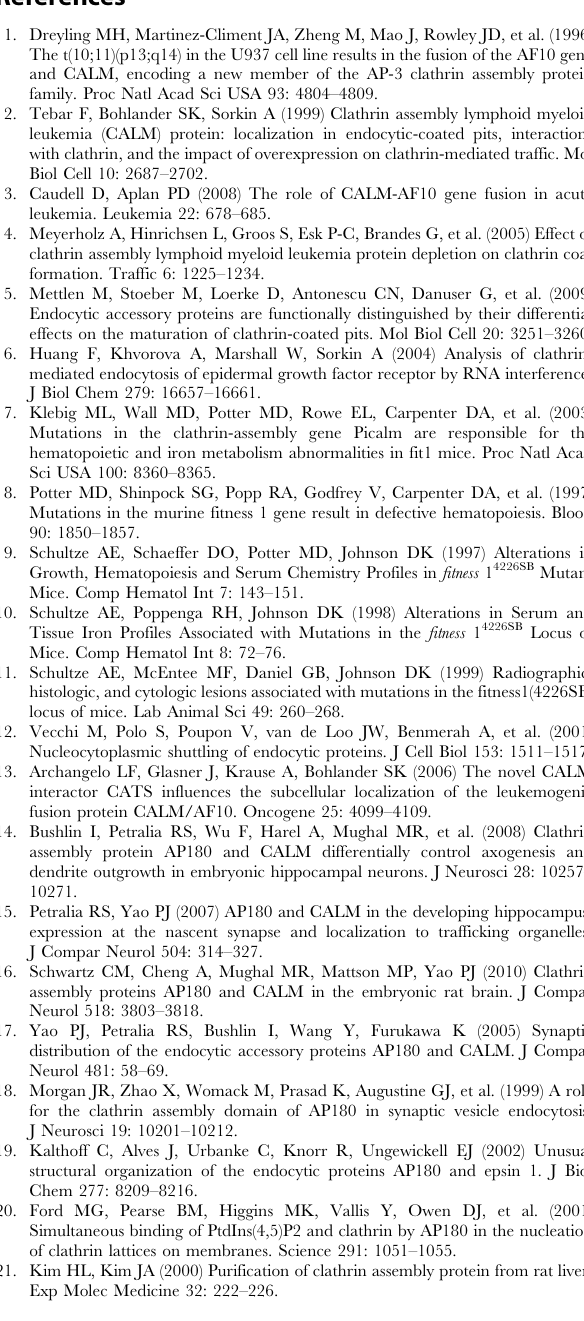
Figure S3 Retroviral expression of PICALM in four independently derived Picalm NULL MEF cell lines res- cues TfR surface expression and endocytosis. (A) Kinetics of TfR internalization in independently derived immortalized Picalm NULL lines (3T, 24T, 29T, 31T). Percentage of surface TfR internalized is shown for untransfected (Null), empty vector transfected (Control) and PICALM -transfected MEFs. (B) Relative surface TfR expression in four immortalized MEF PICALM- deficient MEF lines (3T, 24T, 29T, and 31T) derived from three different pregnancies. Surface TfR levels of empty vector transfected (Control) and PICALM -transfected MEFs are shown relative to untransfected (None)